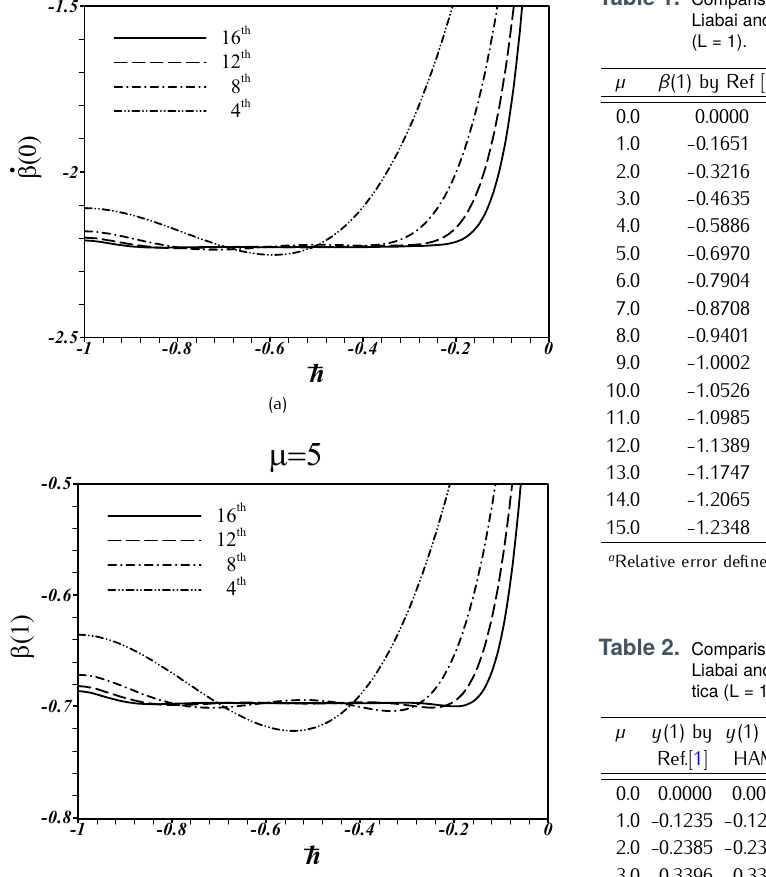
Table 1. Comparison of the HAM solution and numerical solution by Liabai and Simmonds [1] for tip rotation of a heavy elastica (L = 1).